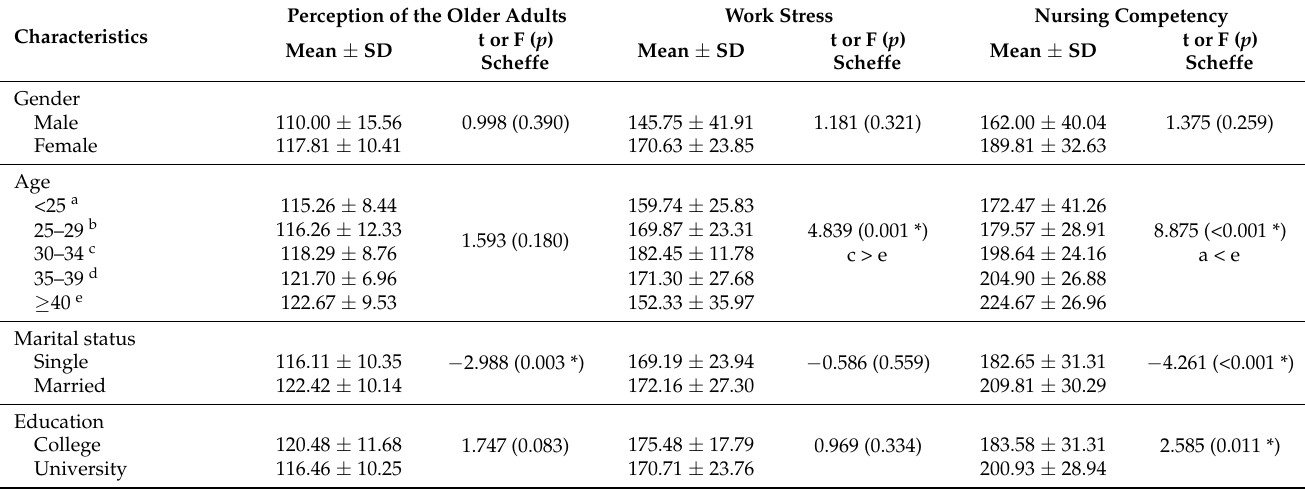
Table 2. Differences on perception of the older adults, work stress, and nursing competency according to the general characteristics of the study